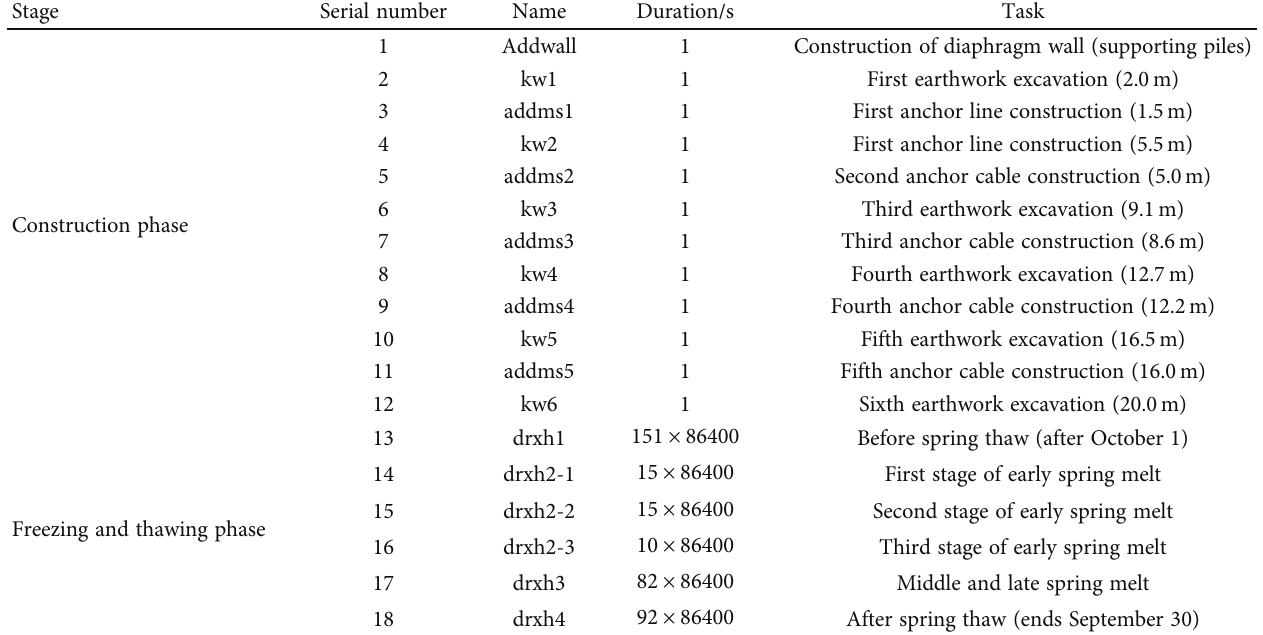
Table 4: Simulation